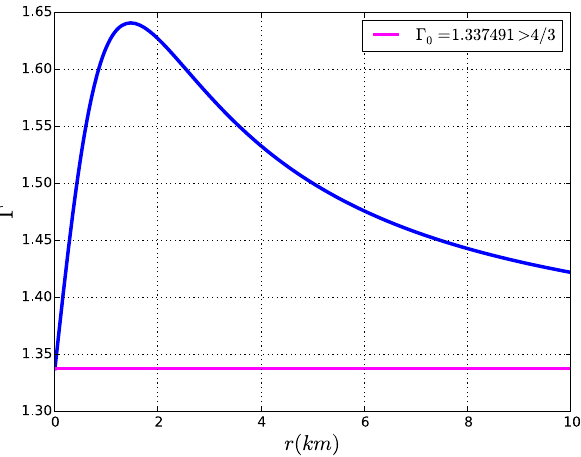
Fig. 13 Behaviour of forces against radial distance r